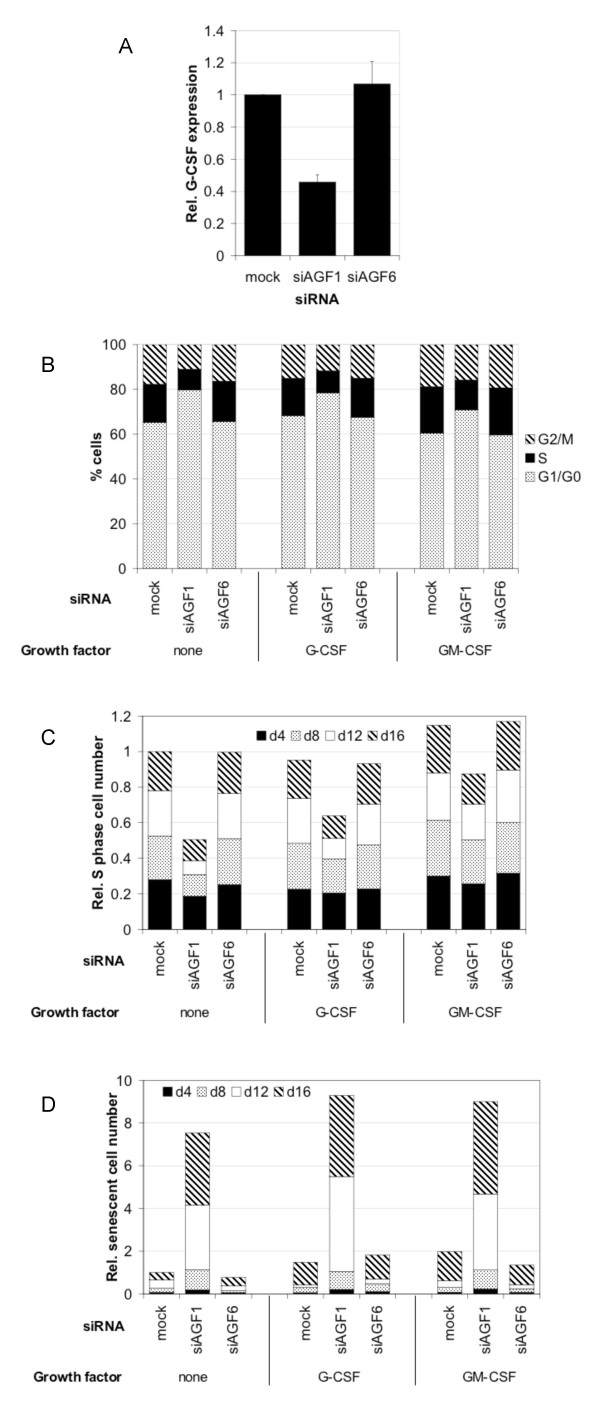
Effects of growth factors on the cell cycle distribution and extent of senescence of siRNA-treated Kasumi-1 cells A. Autocrine G-CSF expression in dependence on the siRNA treatment. Kasumi-1 cells were electroporated at days 0 and 4. Total RNA was isolated on day 8 and analyzed by real-time RT-PCR. The columns and error bars represent the means and standard deviations of three independent experiments. B. Cell cycle distribution of siRNA-treated cells in the absence and presence of growth factors. Kasumi-1 cells were analyzed on day 8 by FACS analysis as described in Materials and Methods. C. Amount of S phase cells in dependence on the length of RUNX1-CBFA2T1 depletion. D. Amount of senescent cells dependence on the length of RUNX1-CBFA2T1 depletion. Growth factors are indicated below the graphs. The data shown in B, C and D were obtained from the same time course experiment. Cells were electroporated with the indicated siRNAs at days 0, 4, 8 and 12, and were analyzed on days 4, 8, 12 and 16.